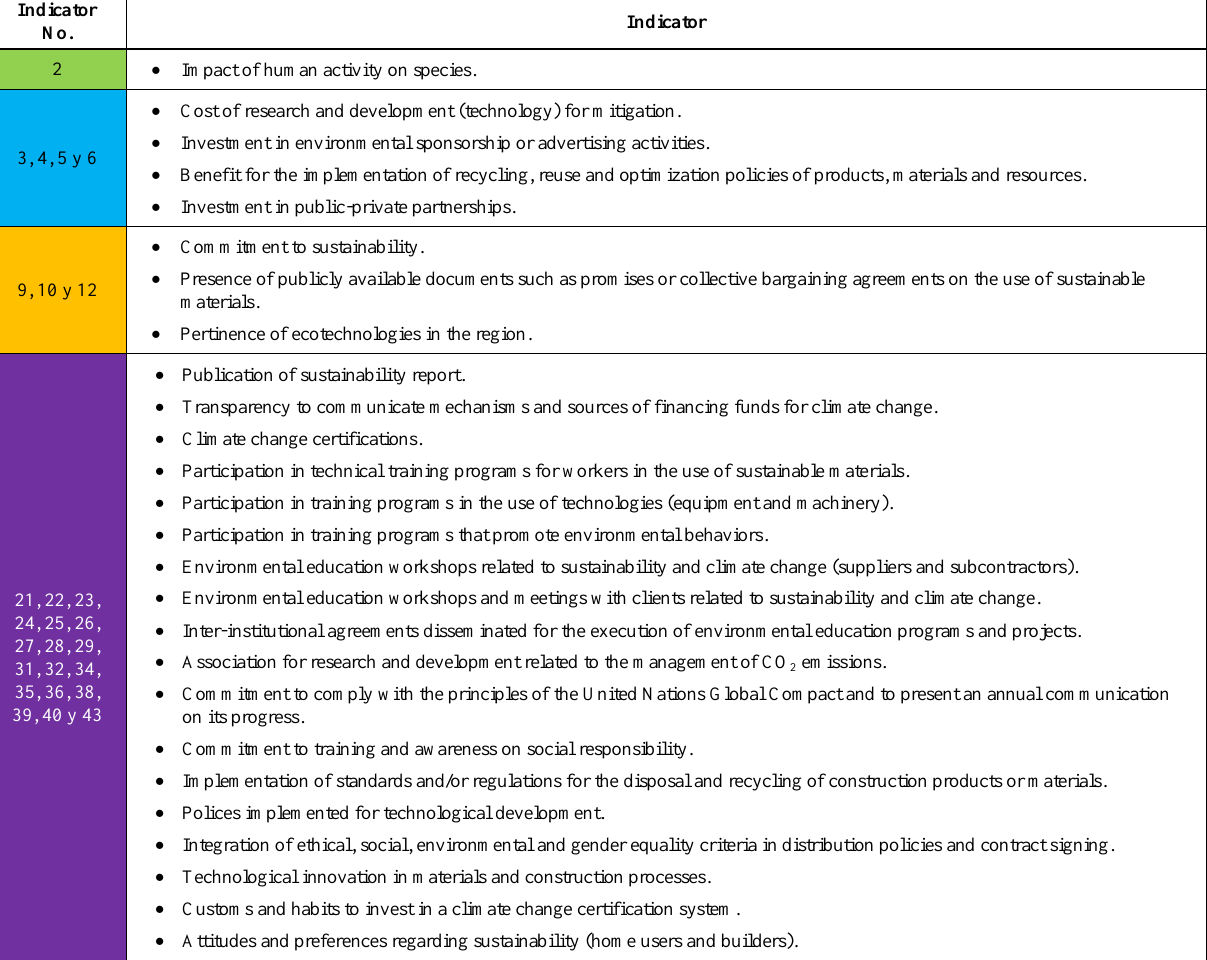
Table 2. Climate change critical